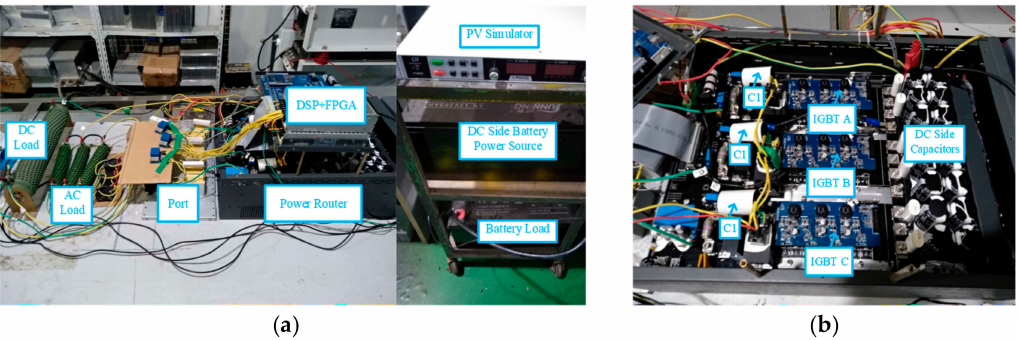
Figure 18. ( a ) Experimental Prototype; ( b ) Main Circuit of PR.